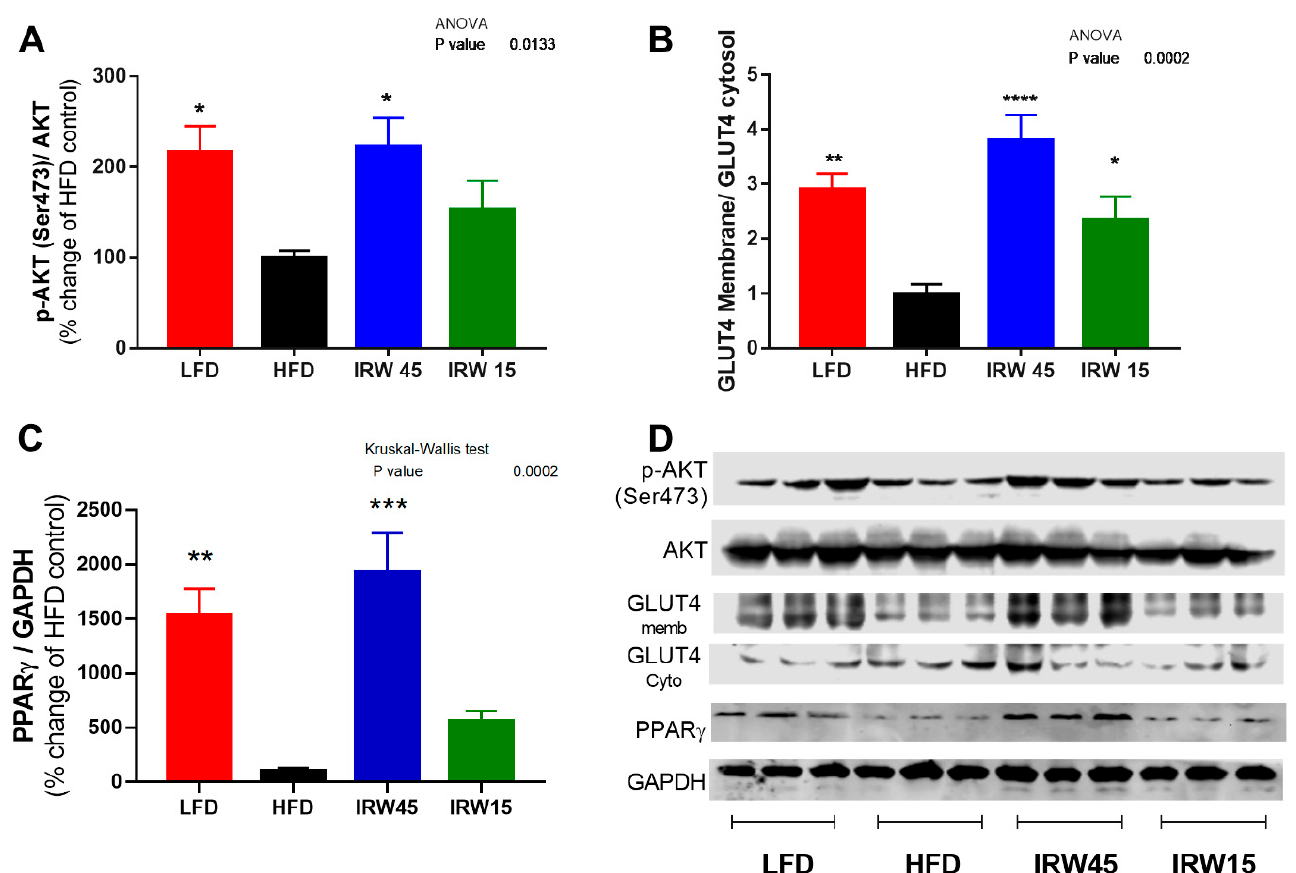
Figure 2. Skeletal muscle insulin signaling and PPAR γ abundance. ( A ) p-AKT, ( B ) GLUT4 membrane/cytosol, ( C ) PPAR γ , and ( D ) representative blots. p-AKT was normalized to total AKT. GLUT4 is expressed as a ratio of membrane to cytosolic GLUT4. PPAR γ was normalized to GAPDH. Data expressed as mean ± SEM of n = 6. Analysis by one-way ANOVA followed by Bonferroni’s post-hoc test or Kruskal–Wallis followed by Dunn’s post-hoc test. * p < 0.05, ** p < 0.01 *** p < 0.001 and **** p < 0.0001 versus HFD. AKT, Protein kinase B; PPAR γ , Peroxisome proliferator-activated receptor gamma; GLUT4, glucose transporter 4.